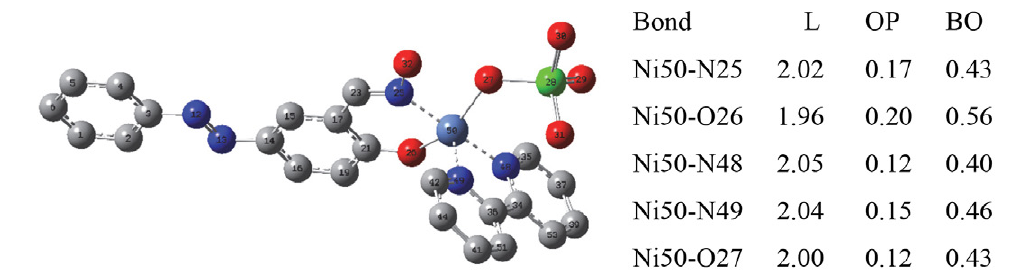
Figure 5: Optimized molecular structure of the complex 3 and selected bond length in Å (L), overlap population (OP) and bond order (BO).